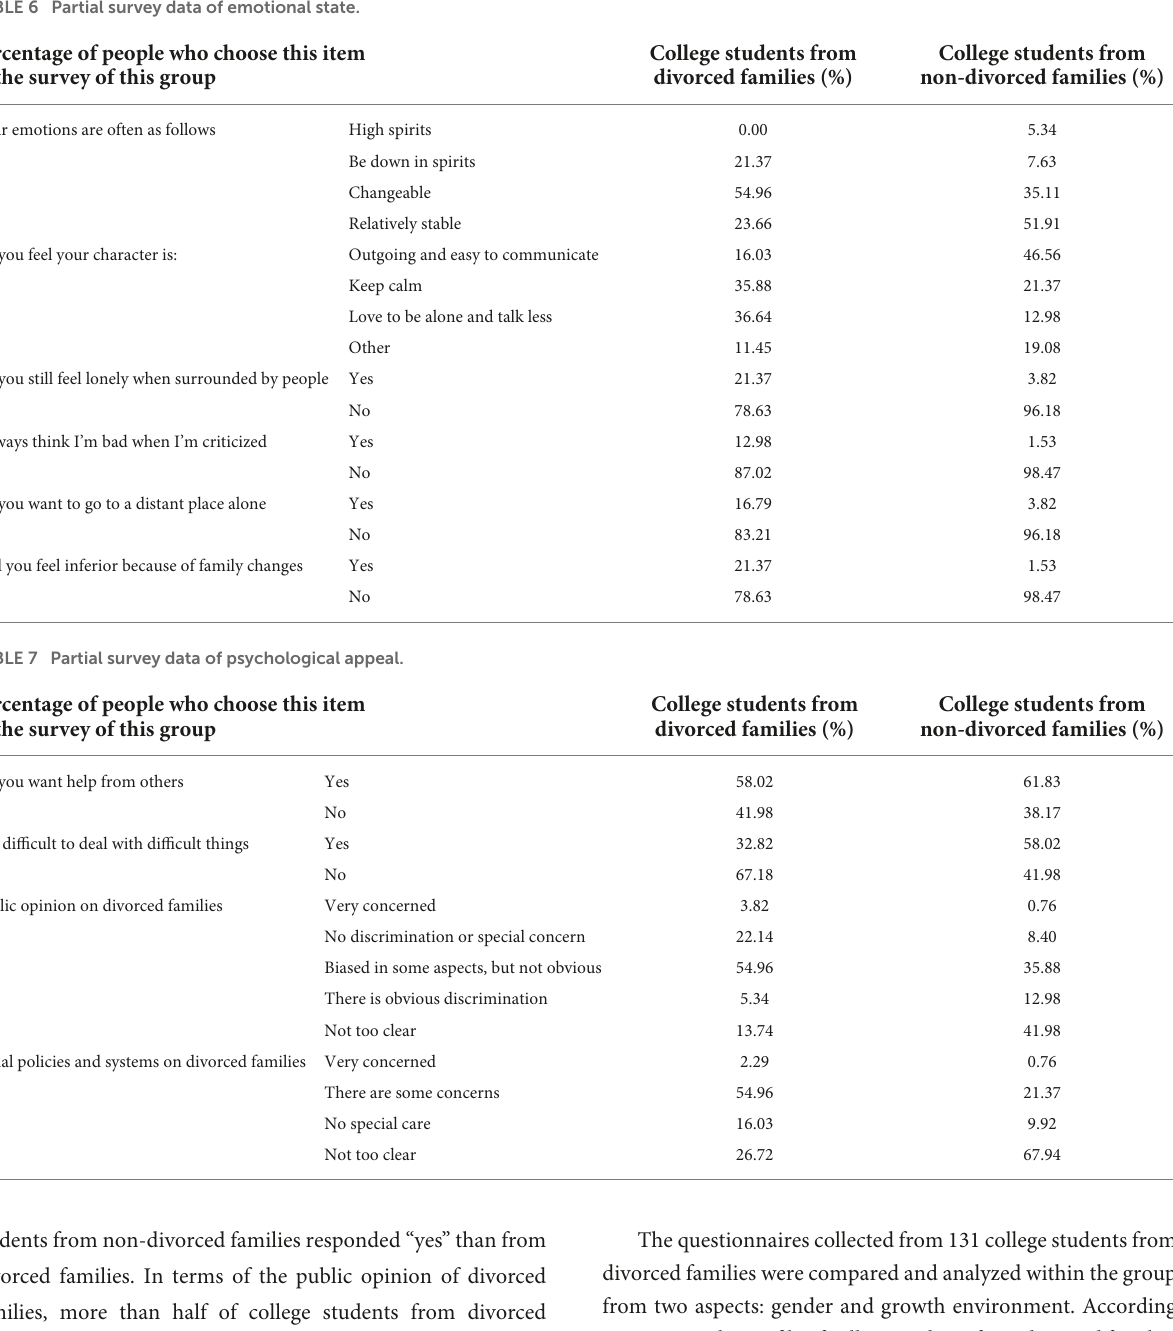
TABLE 6 Partial survey data of emotional state.